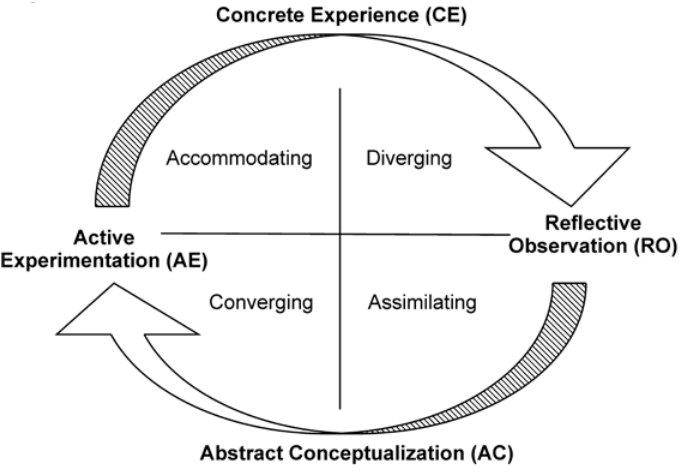
Figure 1. Four learning stages and learning styles (revised from Kolb 1999, p. 4).